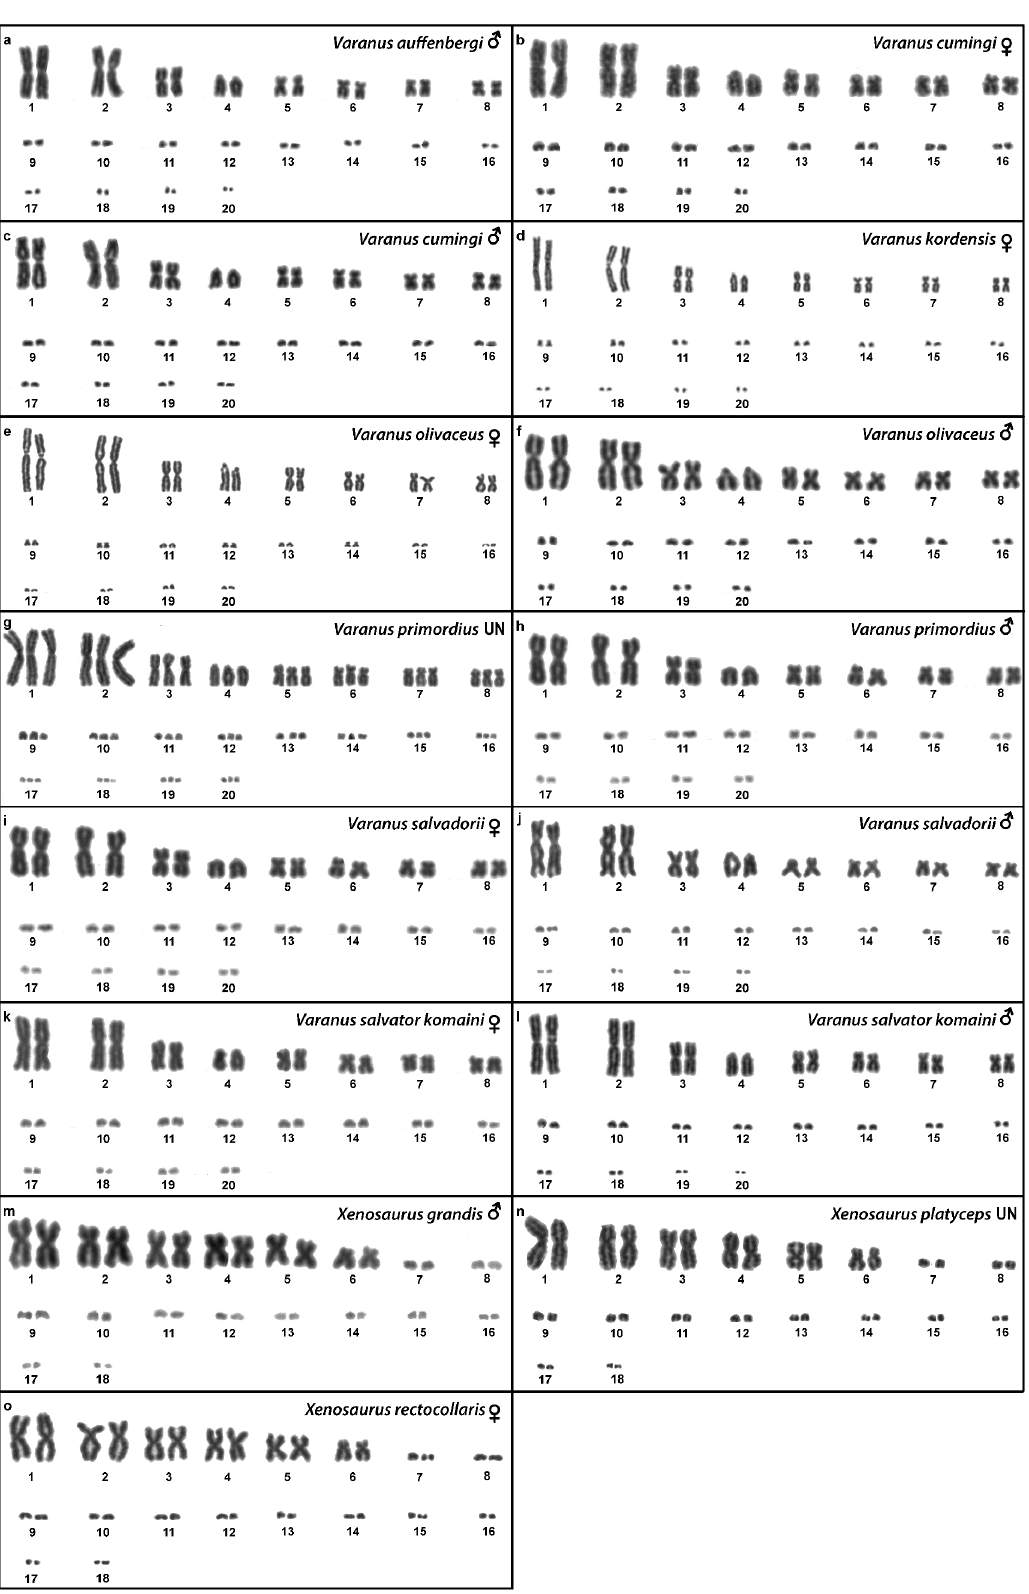
Figure 3. Giemsa-stained karyograms of Varanus auffenbergi ( a ), Varanus cumingi ( b , c ), Varanus kordensis ( d ), Varanus olivaceus ( e , f ), Varanus primordius ( g , h ), Varanus salvadorii ( i , j ), Varanus salvator komaini ( k , l ), Xenosaurus grandis ( m ), Xenosaurus platyceps ( n ) and Xenosaurus rectocollaris ( o ). UN: sex not known.